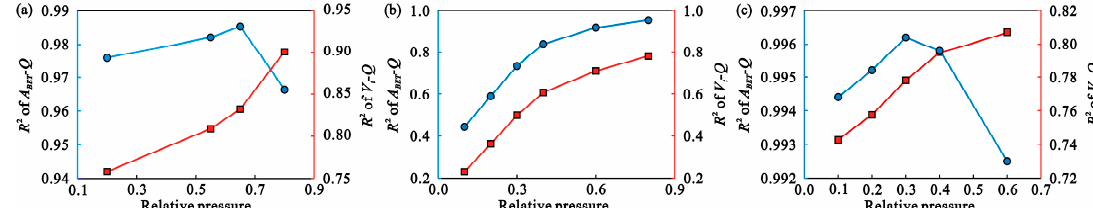
Figure 2. Correlation coefficients for BET surface area and tested hydrocarbon amount ( R 2 of A BET - Q ) shown with blue line and Y-axis, and correlation coefficients for total pore volume and tested hydrocarbon amount ( R 2 of V t - Q ) shown with red line and Y-axis for C 10 H 22 ( a ), C 7 H 14 ( b ) and C 7 H 8 ( c ) with increasing relative pressure.